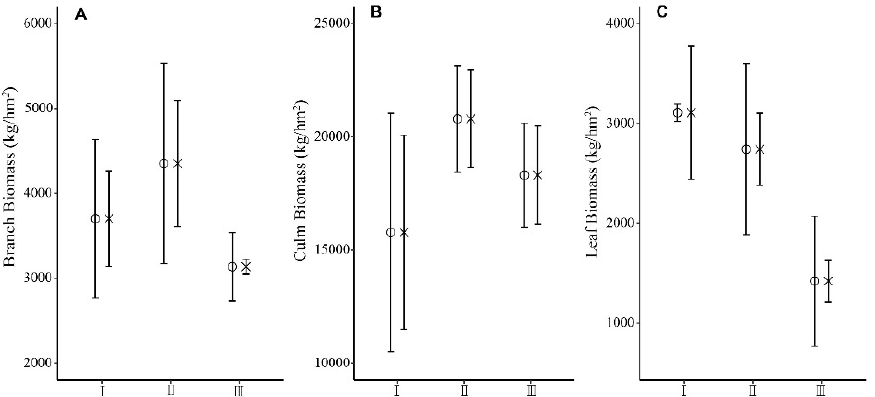
Figure 3. Biomass accumulation of Moso bamboo branch ( A ), culm ( B ), and leaf ( C ) at different ages at the two study sites SC (o) and CK (x). Error bars represent standard deviation (n = 3). Asterisks indicate differences between study sites at different levels of significance: p ≤ 0.001 = ***; p ≤ 0.01 = **; p ≤ 0.05 = *. I “du” bamboo refers to a 1-year-old bamboo, II “du” refers to 2 − 3-year-old bamboo, and III “du” refers to 4 − 5-year-old bamboo.